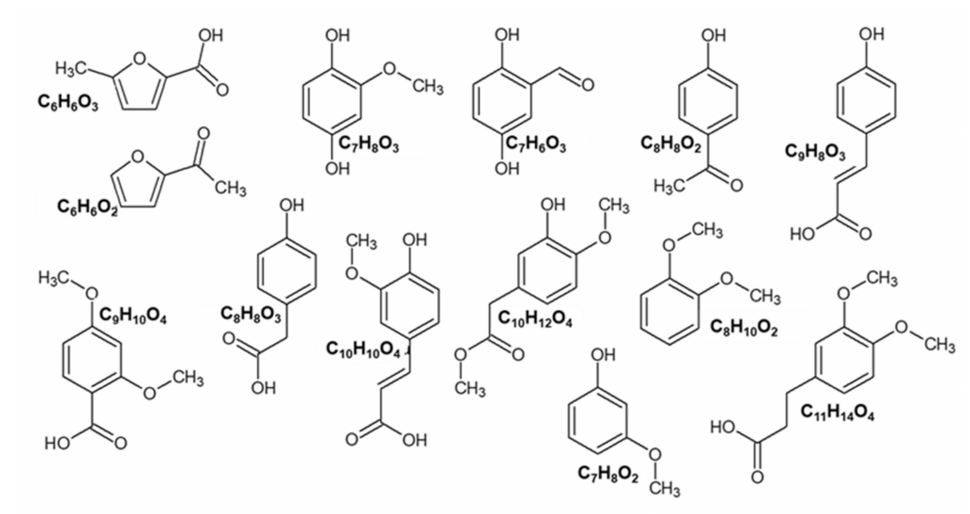
Figure 4. Some of the chemical structures identified from the MS spectra (isomers